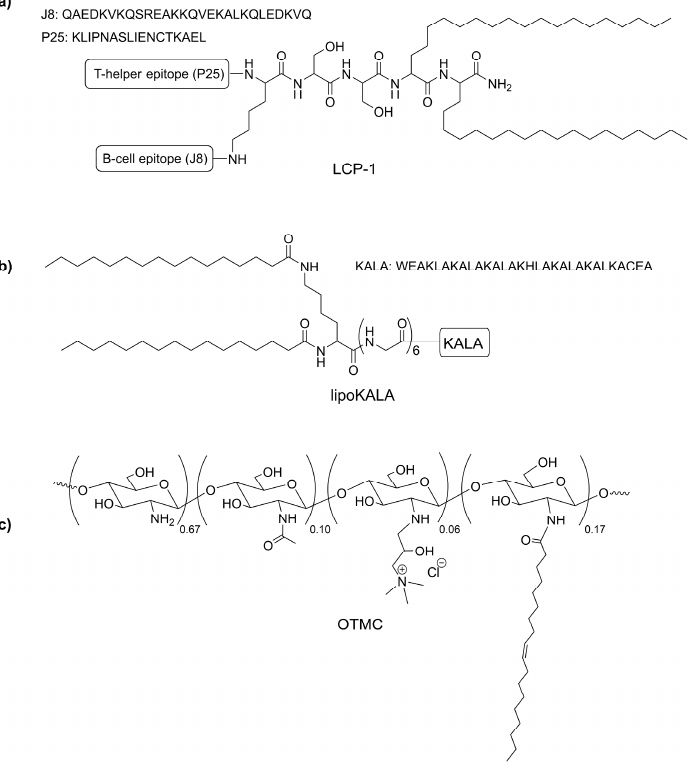
Figure 1. The chemical structure of ( a ) LCP − 1, ( b ) lipoKALA, and ( c ) OTMC.